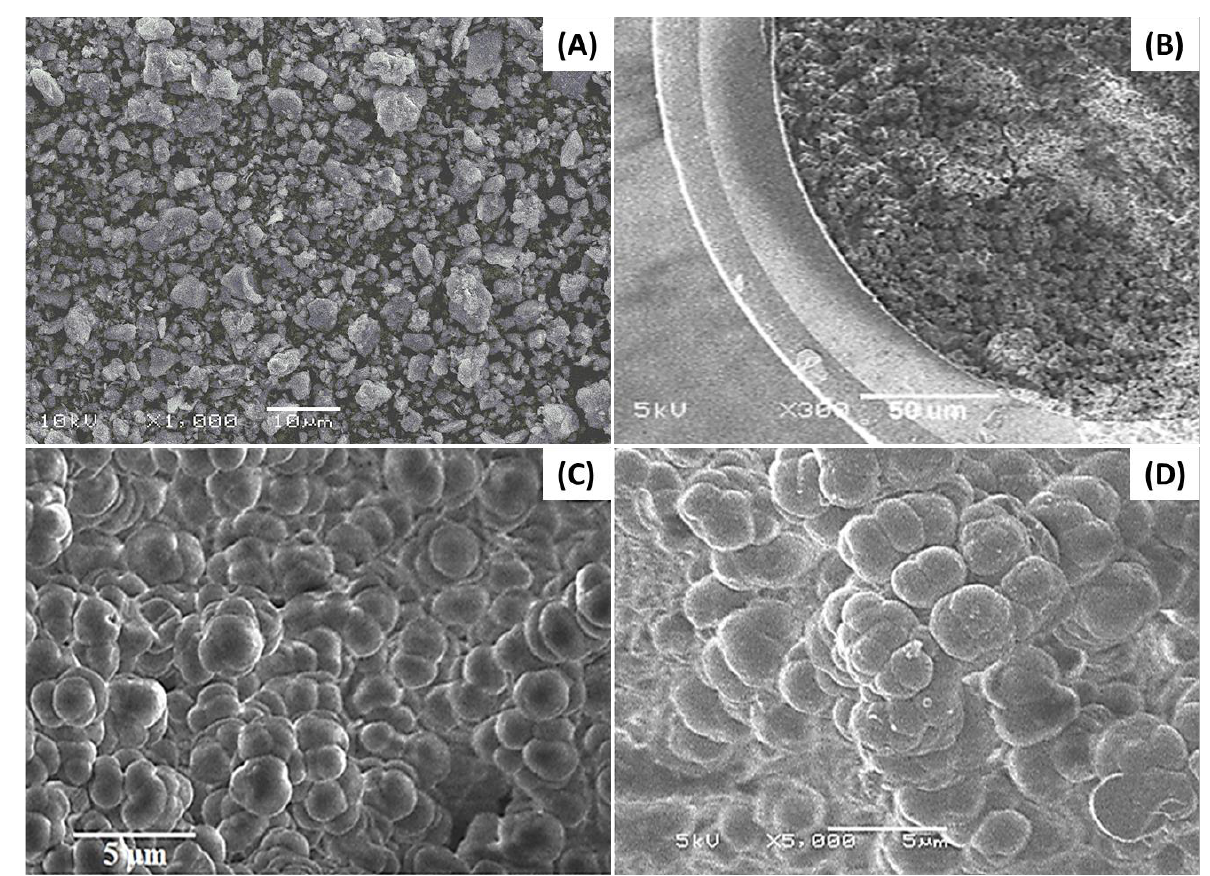
Figure 2. ( A ) SEM image of the MMT after sieving. ( B ) Cross-section SEM image of C G1 column. ( C ) Bulk region SEM image of the C L1 column. ( D ) Bulk region SEM image of the C L4 column.